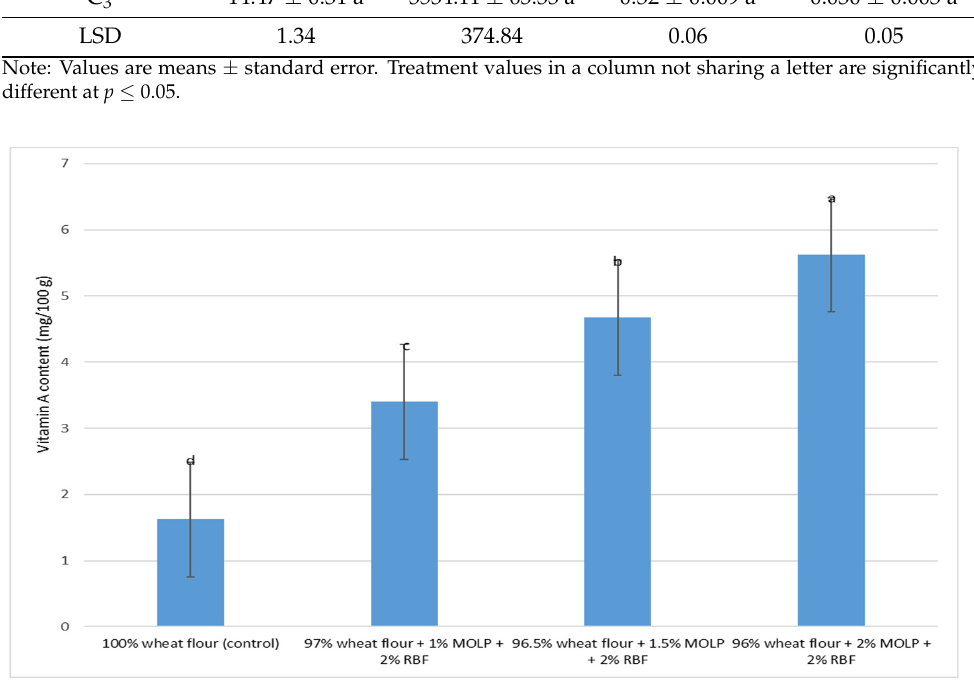
Figure 2. Vitamin A content of MOLP and RBF fortified cakes. Note: Treatment values in a bar not sharing a letter are significantly different at p ≤